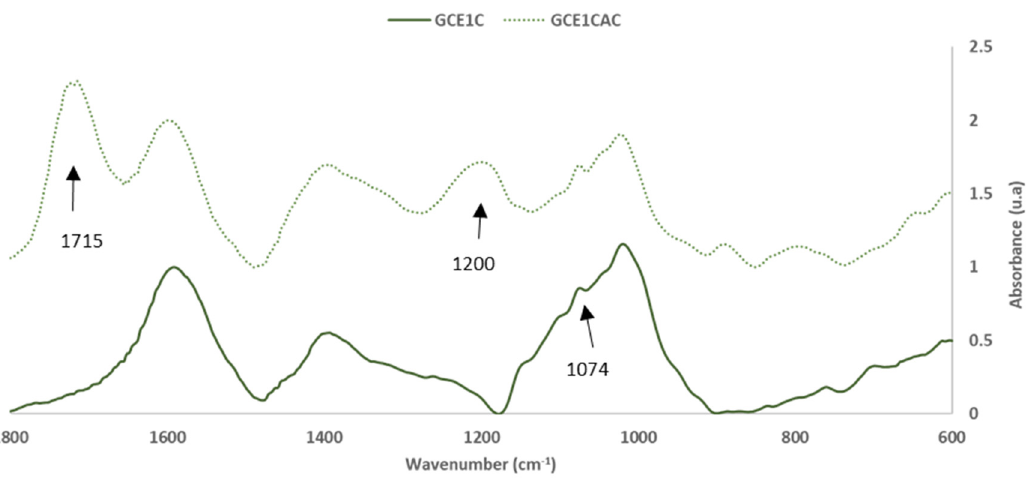
Figure 6. FTIR spectra: Grape cane extracts GC E1 cured alone GC E1 C, and with citric acid GC E1 CAC (600–1800 cm − 1 ).